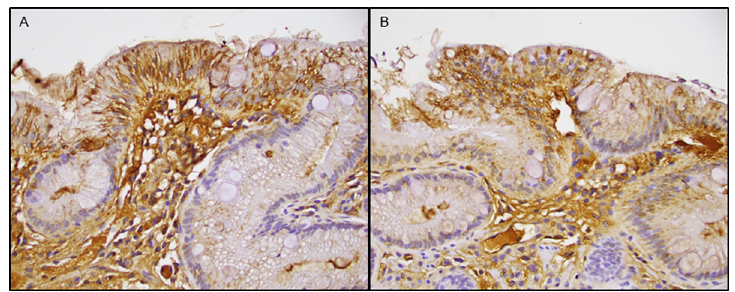
Fig 3. Immunohistochemistry of Barrett’sesophagus for 15-PGDH before and after Vitamin D supplementation. (A) 15-PGDH immunostaining prior to vitamin D supplementation. (B) 15-PGDH immunostaining after vitamin D supplementation within the same individual.Note no difference in staining betweenthese two samples.